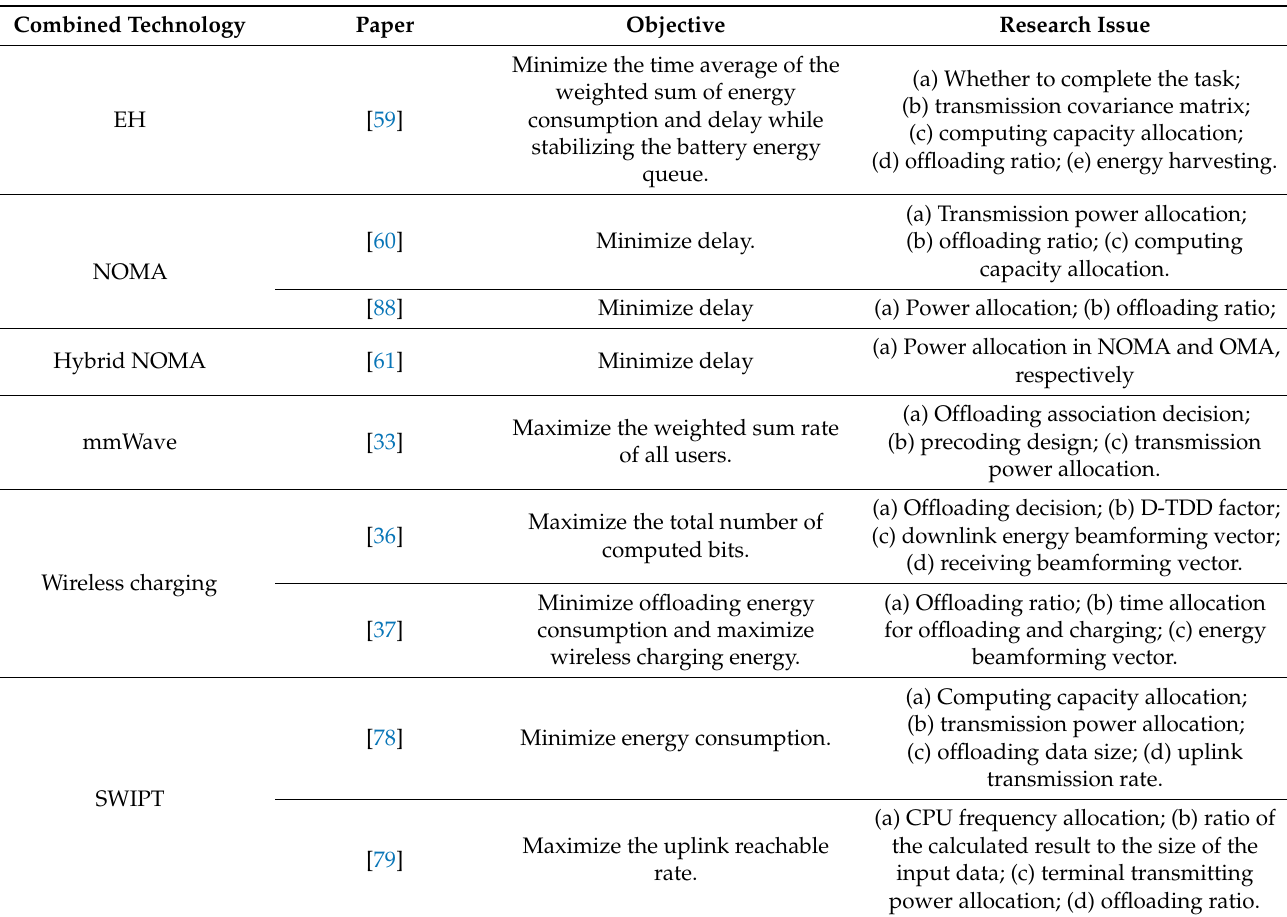
Table 3. Comparison of Research Objects and Issues Combined with Different